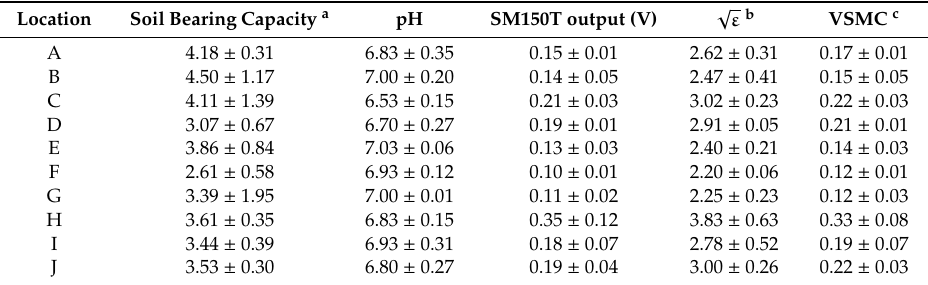
Table 4. Soil data collected from plant